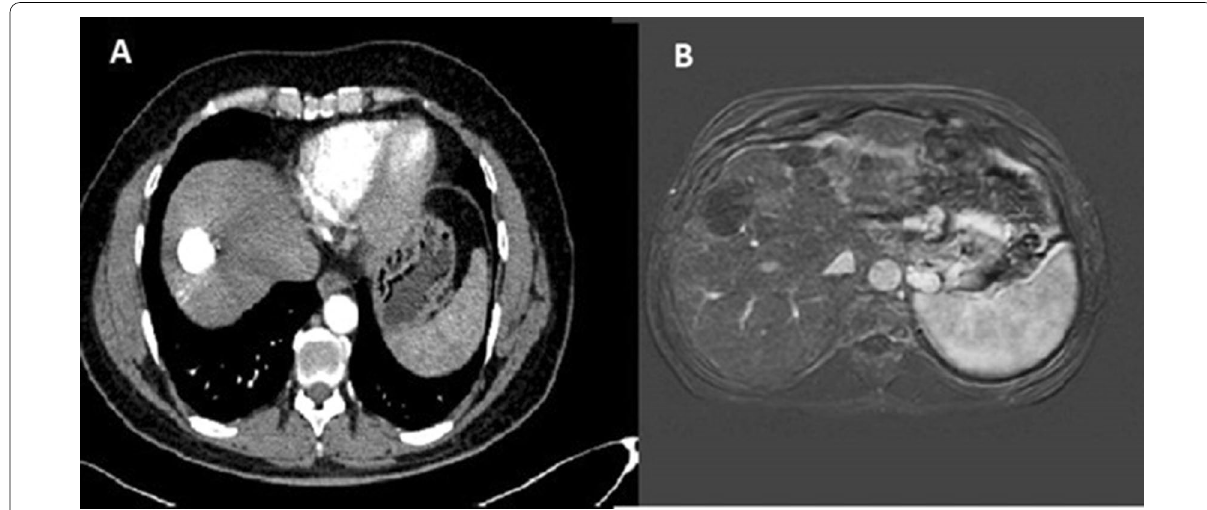
Fig. 2 Complete response: A CT image showing complete Lipiodol deposition with no areas of tumoral arterial enhancement. B MR image showing no intratumoral